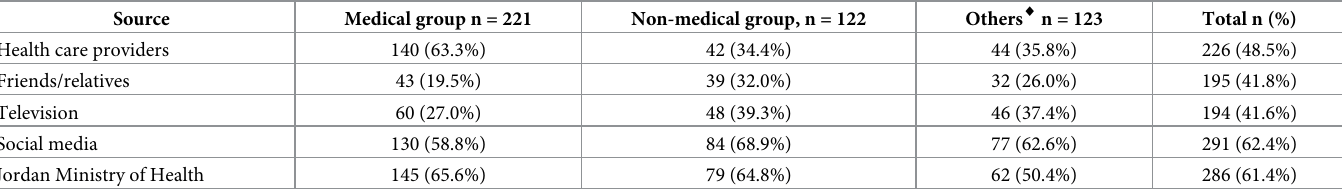
Table 3. Participant’s source of